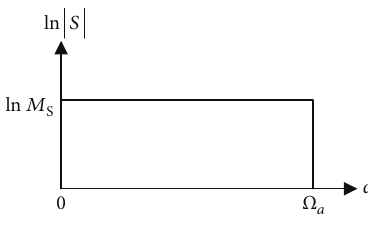
Figure 6: The ideal sensitivity